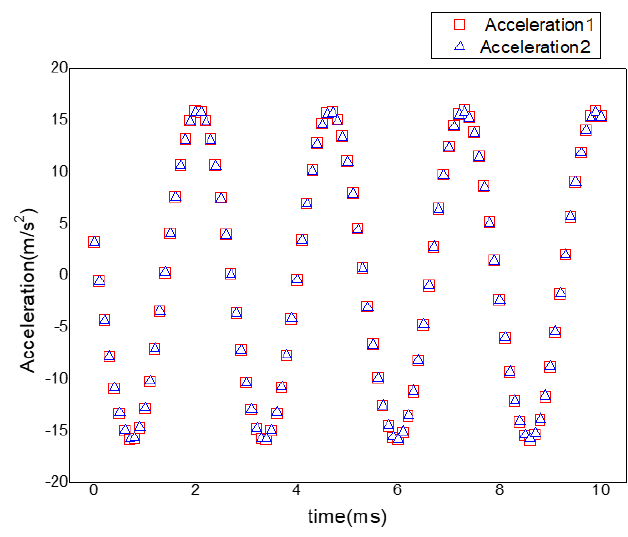
Figure 4. Acceleration response tests of aluminium alloy 7050.